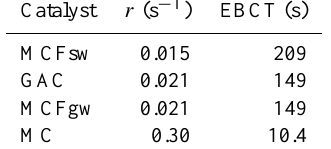
MCFgw equals about 150 s. The EBCT of MC is much lower with approximately 10